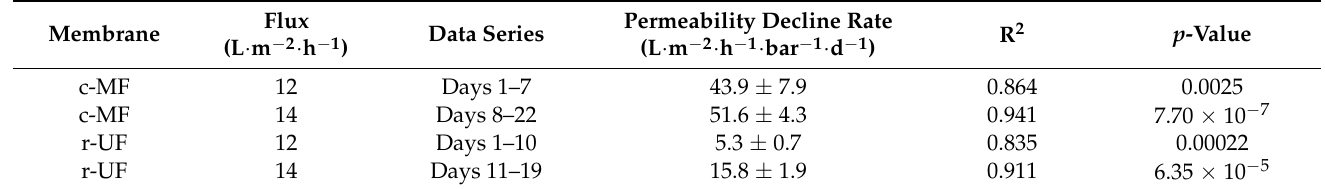
Figure 6. ( a ) Permeability evolution for the c-MF membrane in stages Ia and Ib and ( b ) the r-UF membrane in stages IIa and IIb.